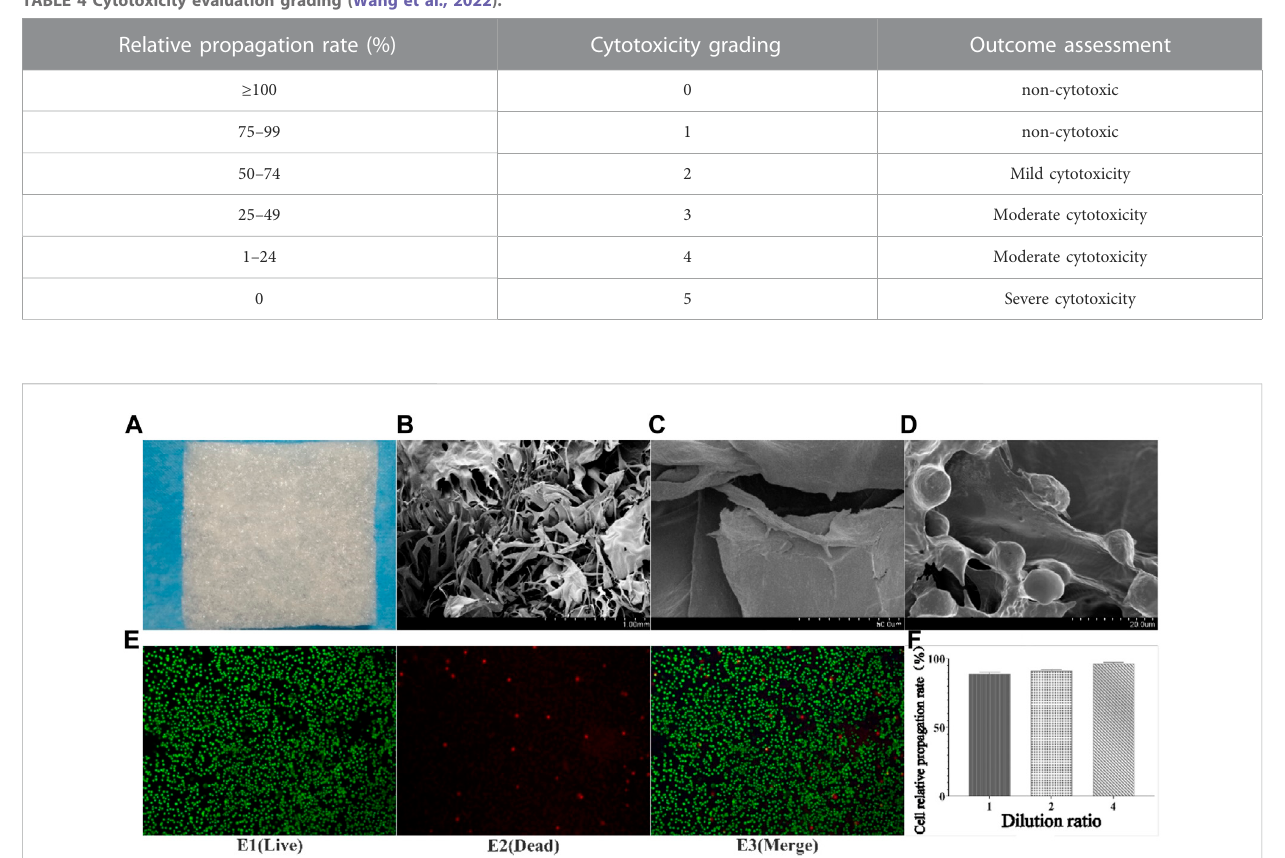
FIGURE 1 Results of collagen preparation, SEM, and co-culture with cells. (A) Collagen sponge; (B) SEM results of collagen sponge (Low multiples); (C) SEM results of collagen sponge (high multiples); (D) Crawl and growth of cells inside collagen sponge; E1-E3: Staining results of live/dead cells after 3 days of co-culture of sponge and cells; F: Relative proliferation rate of